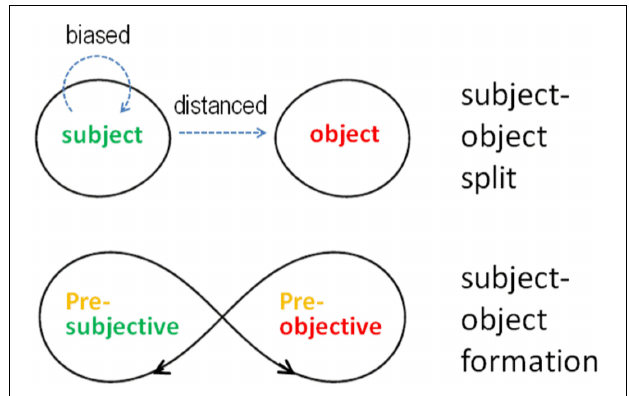
FIGURE 3 | Research attitudes. The common research attitude of modern science pre-supposes the subject–object split, whereas the meditative approach of Structure Phenomenology gains experiential access to the subject–object formation.